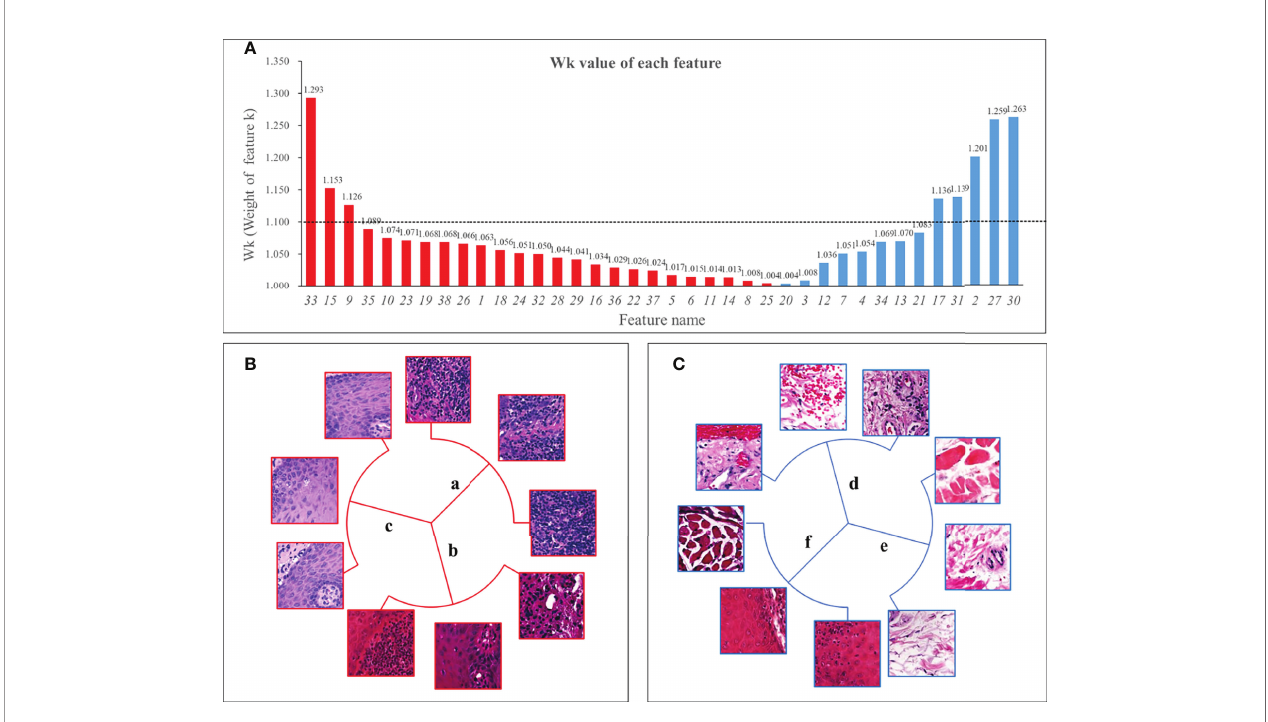
FIGURE 4 | W k (Weight of feature k) of all features and 6 key features. Panel (A) showed the W k values of all features with the vertical axis taking the value of 1 to 1.35. The higher the value, the greater the impact on immunosuppressive treatment ’ s ef fi cacy. We used 1.1 as the threshold and de fi ned features with W k higher than 1.1 as key features. Panel (B) shows 3 positive features, 2 of which were mainly lymphocyte-in fi ltrated lamina propria and additionally contain a small amount of basal cell layer and spiny layer (B. a, B .b ) . There was also a positive feature containing mainly the epithelial layer and, in addition, an in fi ltration of lymphocytes (B .c ) . Among the negative features, one feature contained patches with the blood vessels (C .d ) ; one feature was loose connective tissue (C. e ) ; and one feature was the lamina propria, which contained part of the epithelial layer but not lymphocyte-rich areas (C. f ) .